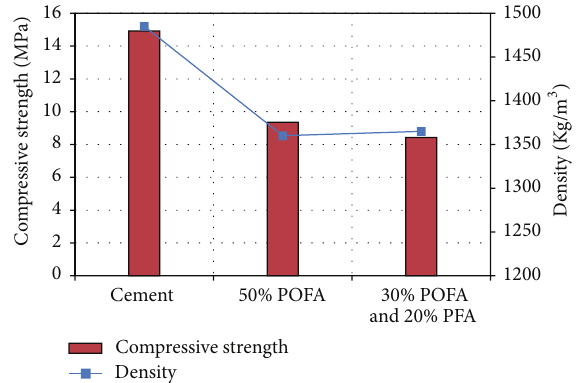
Figure 3: Relationships between compressive strength and density for aerated concrete (28 days).